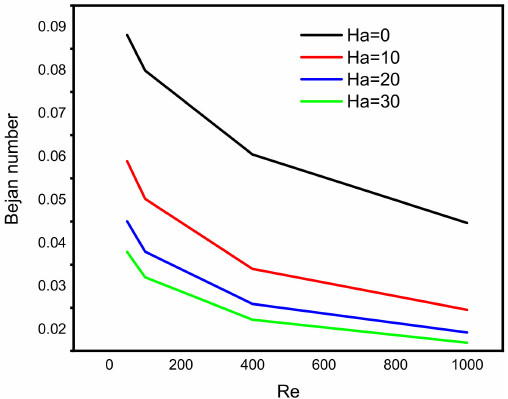
Figure 6. Variation in Bejan number with Reynold number at different levels of Hartmann